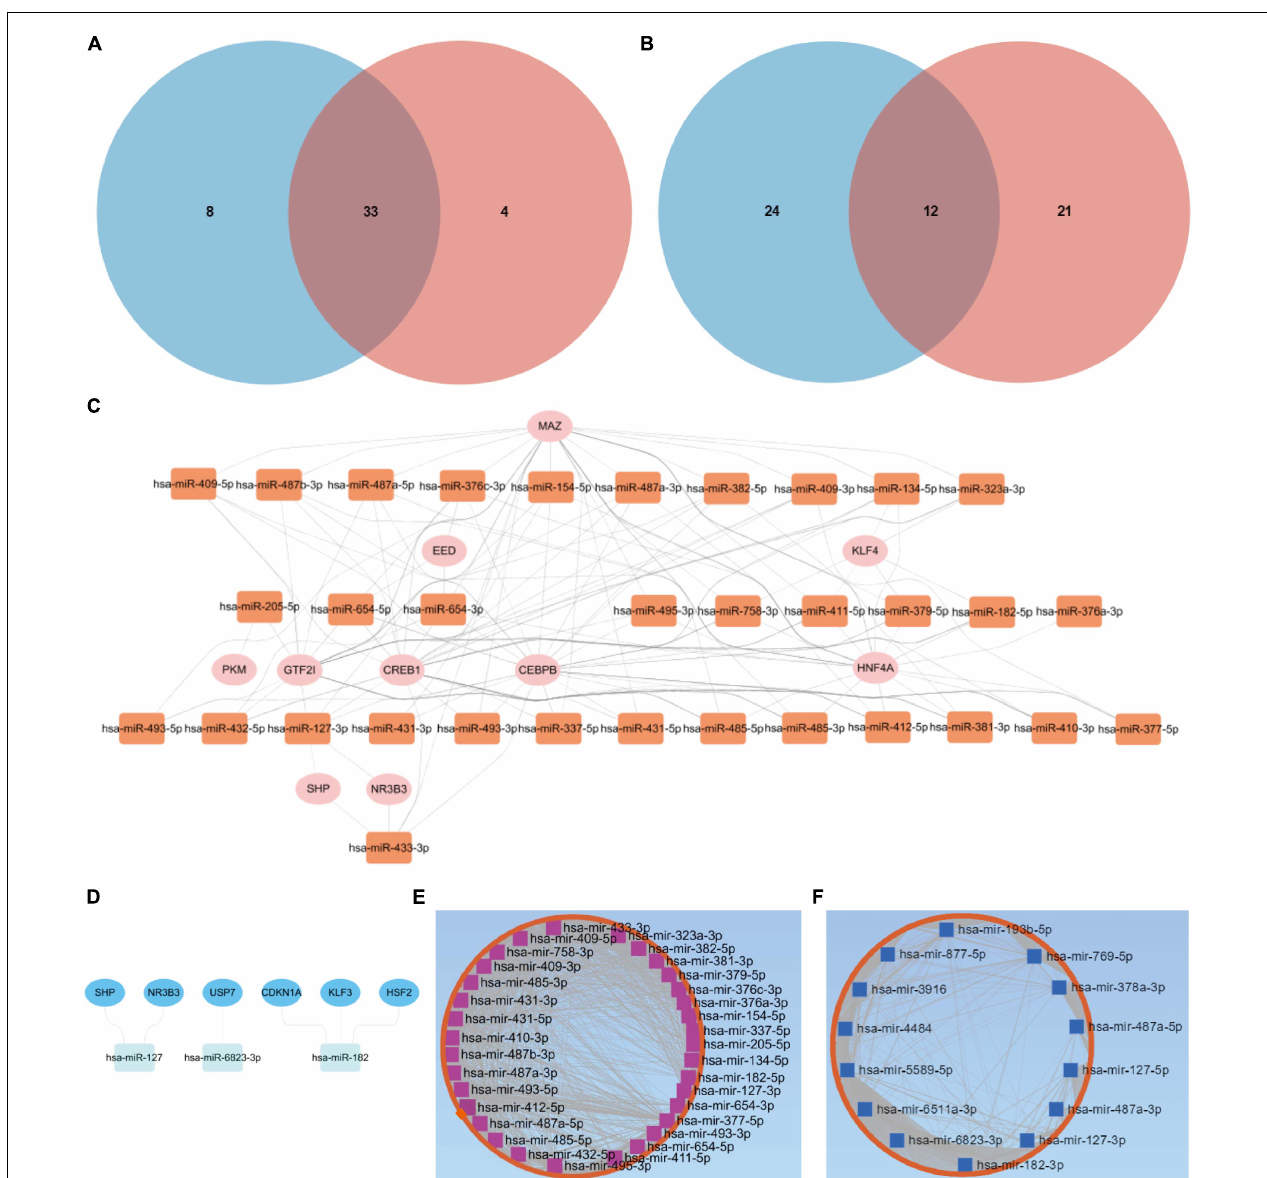
FIGURE 2 | Putative TFs and target genes of the hub miRNAs. (A) The intersection of the two clusters of upregulated DE-miRNAs. (B) The intersection of the two clusters of downregulated DE-miRNAs. Putative TFs for (C) upregulated or (D) downregulated hub miRNAs. (E) Upregulated or (F) downregulated hub miRNA-target gene network. DE-miRNAs, differentially expressed microRNAs; TFs, transcription